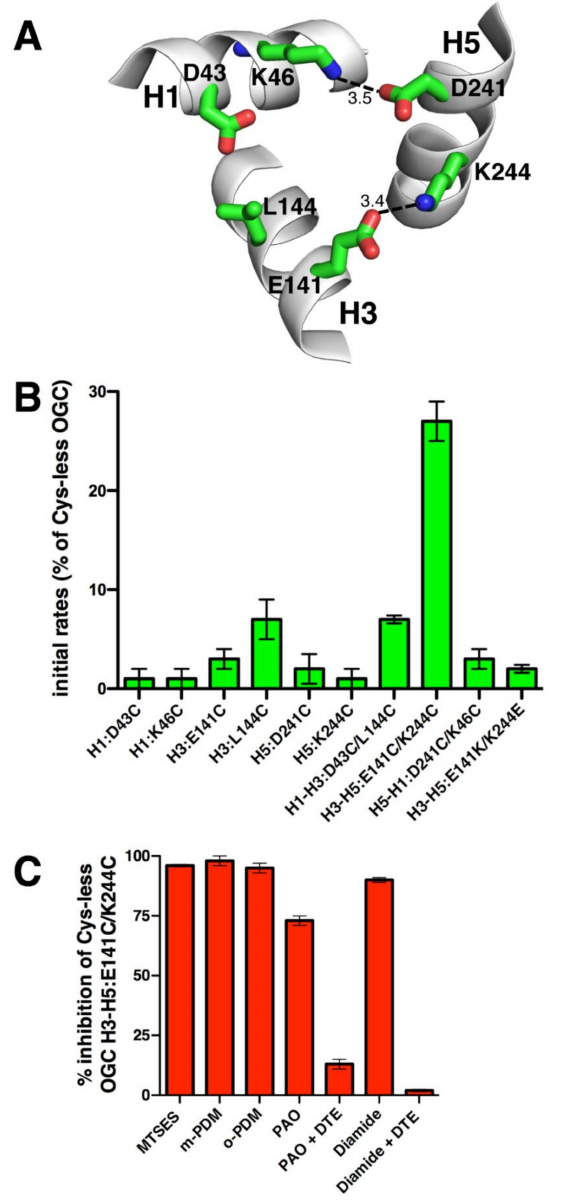
Figure 2. Initial transport rates of the OGC cysteine mutants. ( A ) The PX[DE]XX[KR] motifs in the C-state OGC homology model with the salt bridges indicated by lines and distances in Å. ( B ) Initial transport rates of Cys-less OGC cysteine mutant proteins reconstituted in liposomes. Transport was started by adding 3 mM 14 C-labelled 2-oxoglutarate to proteoliposomes containing 20 mM 2-oxoglutarate and stopped after 30 sec by the stop inhibitor method. The activity is expressed as the percentage initial rate of Cys-less OGC, which was 2135( ± 248) µ mol/min/g protein. The means ± S.D. of at least three independent experiments carried out in duplicate are shown. The results for the single OGC cysteine mutants have been published previously [30]. ( C ) Liposomes reconstituted with OGC H3-H5:E141C/K244C were treated with the indicated sulfhydryl reagents for 10 min at 25 ◦ C before the transport activity was measured. The inhibition percentages of the initial rate of Cys-less OGC H3-H5:E141C/K244C, which was 568( ± 127) µ mol/min/g protein, are